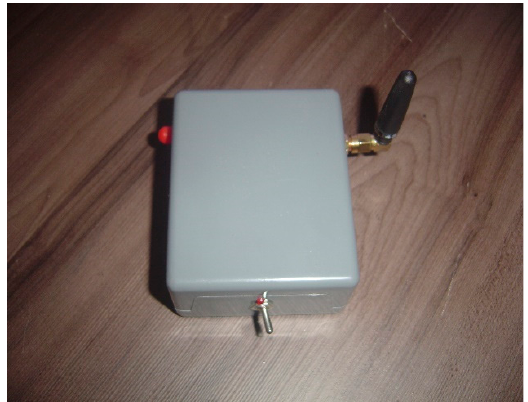
Figure 3. Radio frequency (RF) transceiver used in the computer to communicate with the solar tracker.